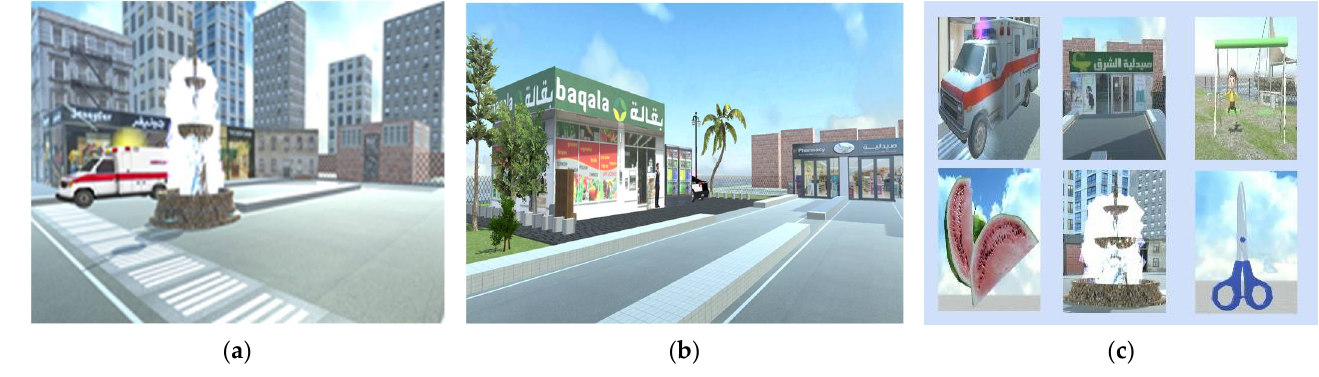
Figure 2. VR system to diagnose dementia patients: ( a ) patients’ roams around the VR; ( b ) memory and delay recall task; ( c ) visual memory task. and delay recall task; ( c ) visual memory